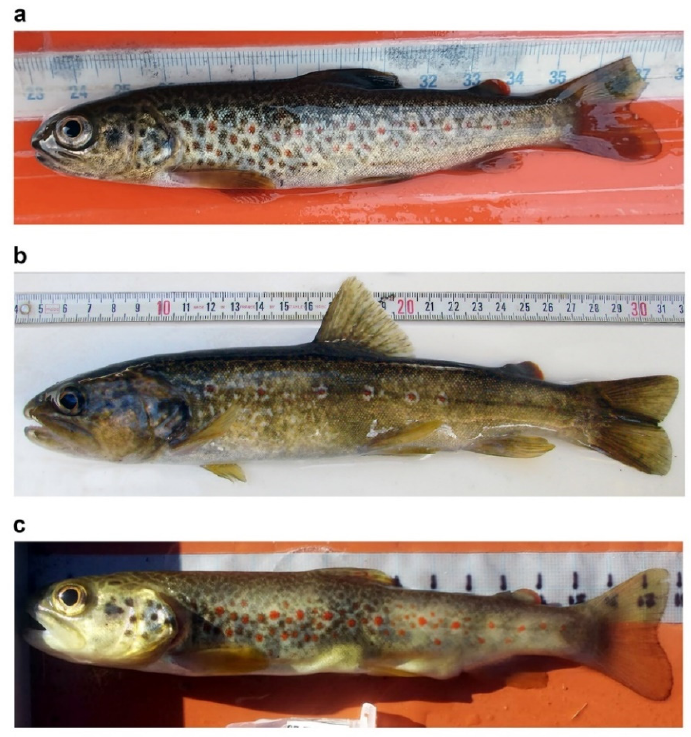
Figure 2. Examples of dotted coloration patterns in S. marmoratus : juvenile coloration pattern ( a ), and adults living in small and fast-flowing streams ( b , c ); ( a ) juvenile from Roledo (Piedmont, Verbano-Cusio-Ossola: VCO; 46 ◦ 10 (cid:48) 16.7 (cid:48)(cid:48) N 8 ◦ 18 (cid:48) 49.7 (cid:48)(cid:48) E), 15.5 cm total length—TL, 29.0 g wet mass, 22 months of age, black-and-red dotted pattern, MA haplogroup, q Ma 0.995 (admixture proportion of a cluster including purebred S. marmoratus references), 90% BCI 0.966–1.000; ( b ) adult (reproductive) specimen from Rio Ischielle, tributary of the Avisio Torrent (Province of Trento); the specimen was collected from a population which resided for 2 generations in this small stream, which descended from hatchery-reared S. marmoratus with marbled phenotype collected from the Adige River [115]; 26.9 cm TL, courtesy of Leonardo Pontalti; ( c ) adult (reproductive) specimen from Rio della Balma, tributary of the Sangone River (Province of Torino), 18.5 cm TL, MA haplogroup, q Ma 0.996, 90% BCI 0.978–1.000, courtesy of Paolo Lo